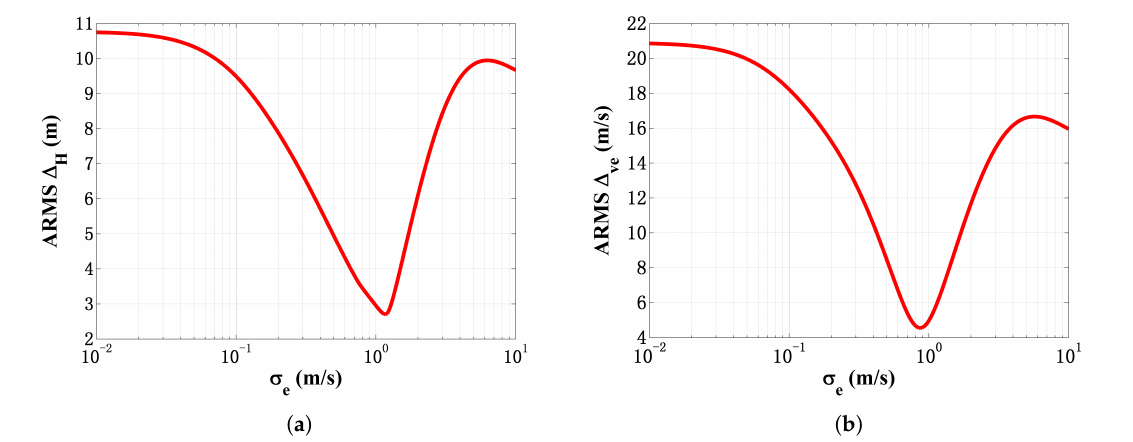
Figure 10. Estimation performance versus σ e from EKF using field data: ( a ) RMS ∆